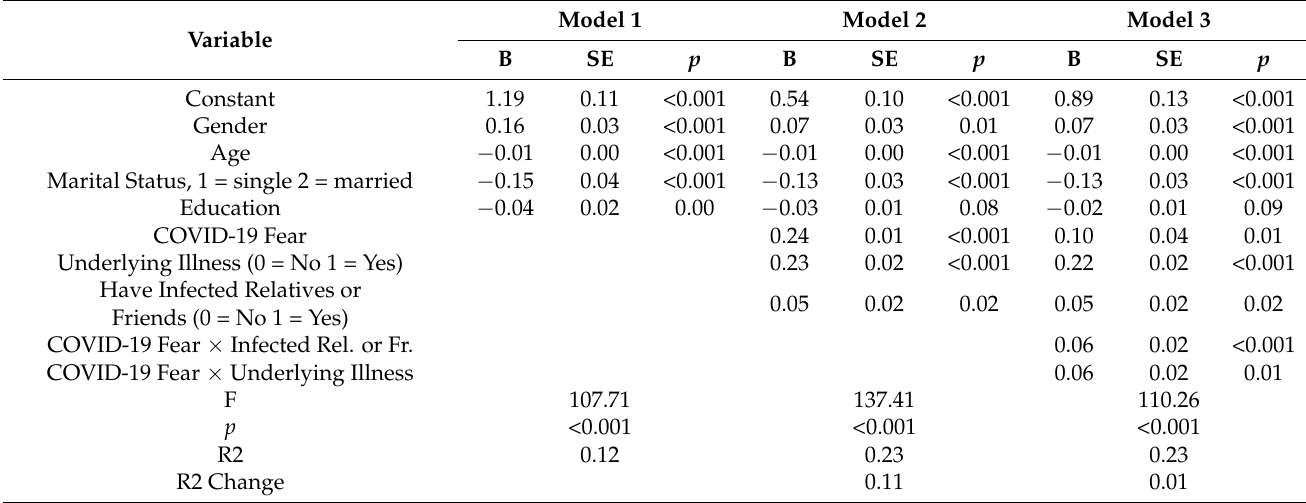
Table 5. Main and Interaction Effects on Stress.